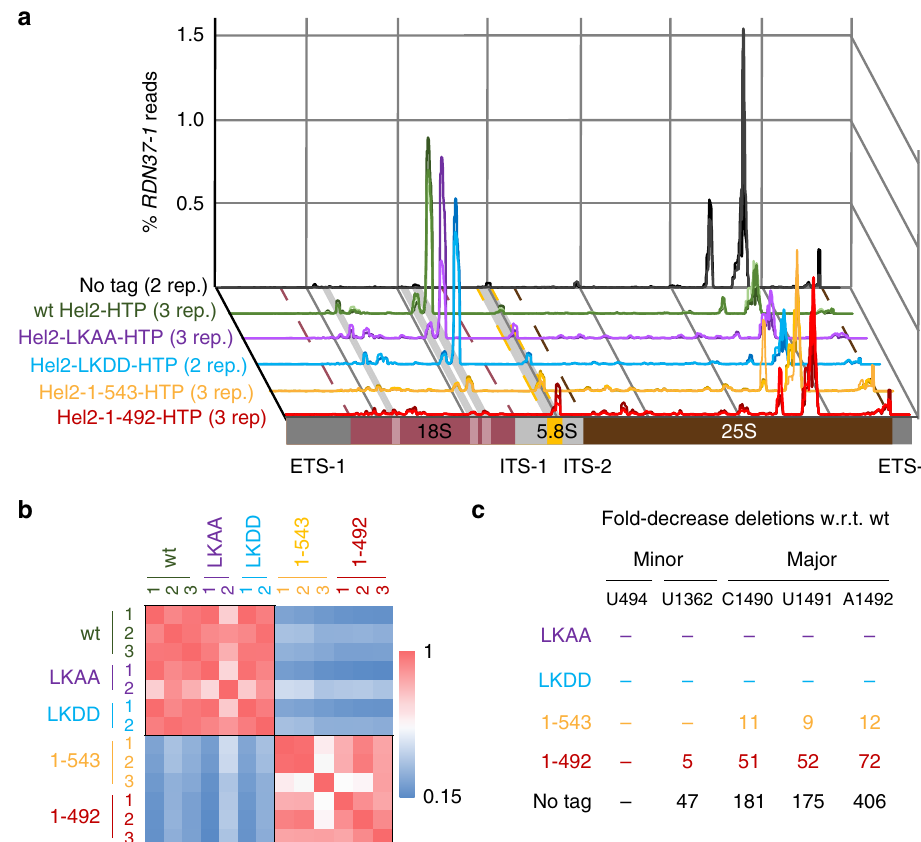
Fig. 4 Effects of Hel2 mutations on binding of ribosomal RNA. a Relative distribution of reads over RDN37-1 gene encoding three of the four ribosomal RNAs. Major and minor 18S peaks and the 5.8S peak are highlighted with grey bars. The 25S peak has been seen in many different crosslinking and analysis of cDNA (CRAC) analyses and appears to be non-speci fi c. Borders of 18S and 25S rRNAs are indicated as dashed lines. The sum of all reads over RDN37-1 is normalized to 1 for each sample. See Supplementary Fig. 6 for schematic depiction of mutants. b Pearson correlation between binding patterns (reads) in different samples. c Change in relative fraction of deletions at previously identi fi ed crosslink peaks in 18S rRNA. Minor (U494, U1362) and major (C1490- A1492) peaks are represented. The sum of all deletions over RDN37-1 was set to 1 for each sample. Medians are only shown for samples of p < 0.05 (two- tailed Student ’ s t test, w.r.t. wild-type). See also Supplementary Fig. 7. For U494, a reduced read density was visible in a , but the frequency of deletions was not signi fi cantly altered, owing to experimental variability in deletion density for the wild-type (Supplementary Fig.